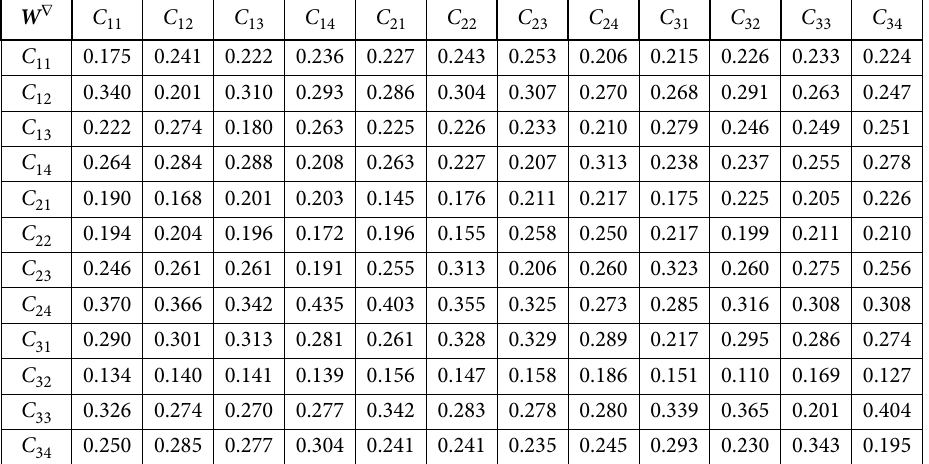
Table 7. Unweighted supermatrix